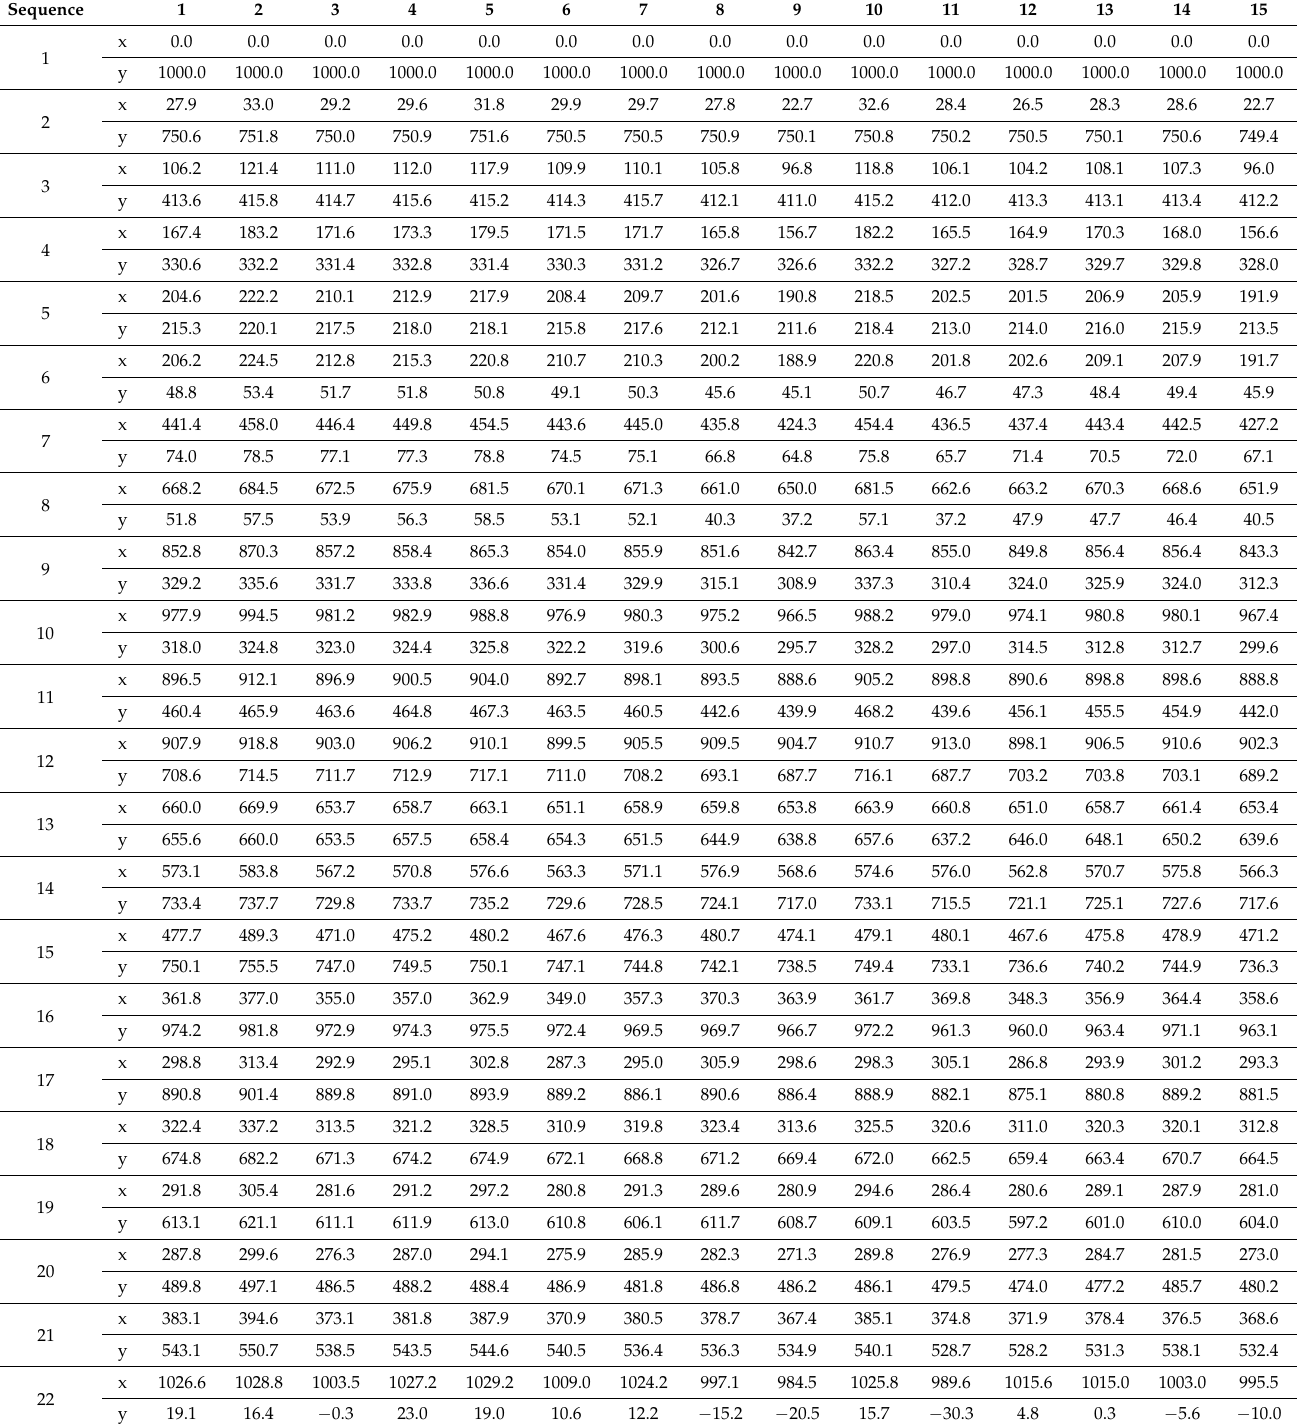
Table A8. Experiment data when moving along the path with the optimal precision. The movement commands are compensated